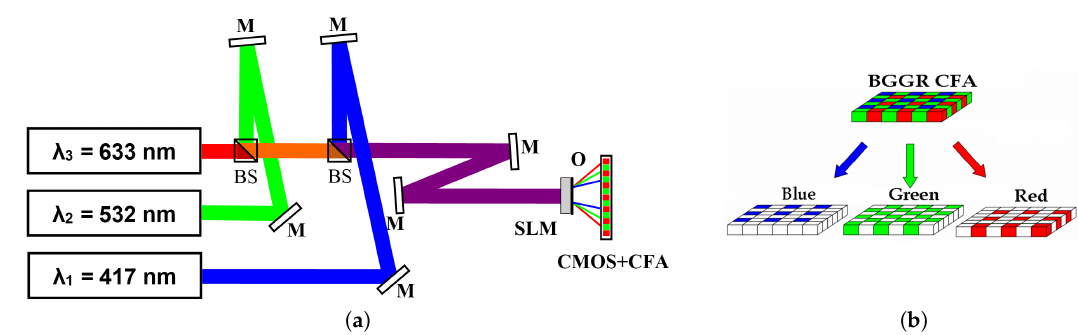
Figure 1. ( a ) Optical setup. λ 1 = 417 nm, λ 2 = 532 nm, λ 3 = 633 nm are wavelengths of the blue, green, and red light sources, M are mirrors, BS are beam-splitters, SLM stands for Spatial Light Modulator, O is the object, CMOS+CFA is a registration camera with CFA; ( b ) Color filter array. BGGR CFA is a blue-green-green-red disposed CFA; Blue, Green and Red are separate color